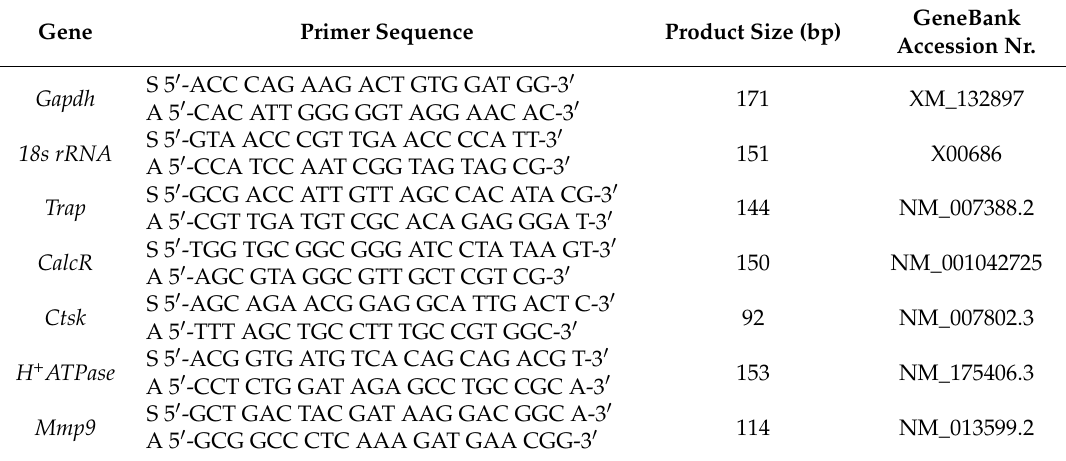
Table 1. Sequence of the specific primers used in the real time RT-PCR analysis of the reference and target genes for the in vitro